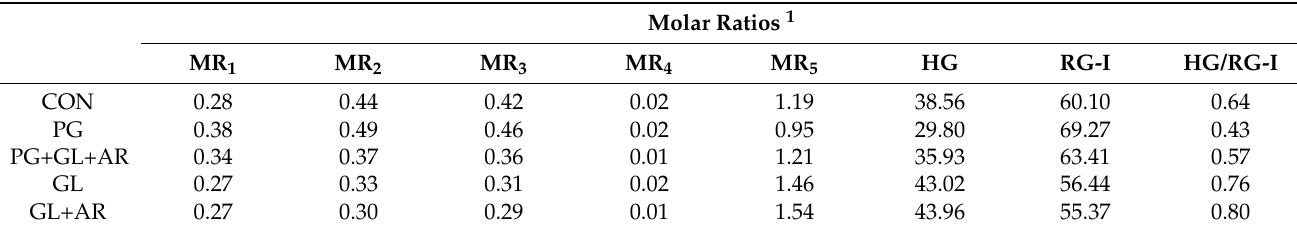
Table 3. Molar ratios of OKPs following enzymatic treatments. Molar Ratios